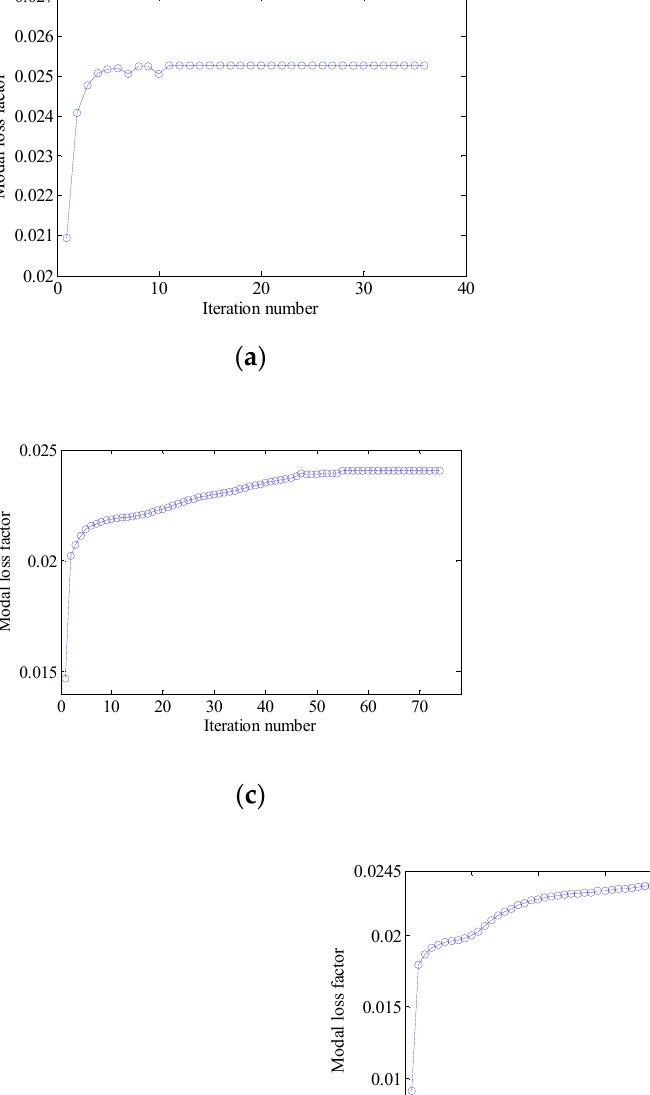
Figure 8. Iteration histories for different penalty factors: ( a )